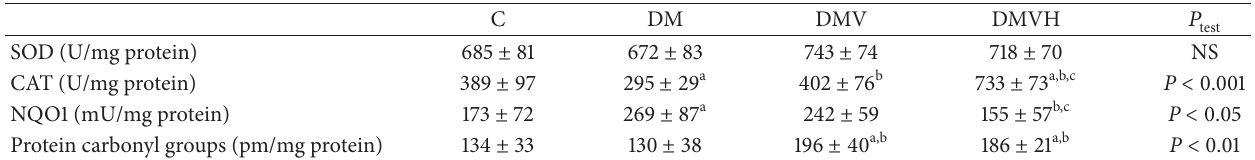
Table 3: Activity of superoxide dismutase (SOD), catalase (CAT), NAD(P)H: quinone-oxidoreductase-1 (NQO1), and protein carbonyl group levels in the liver on day 35.